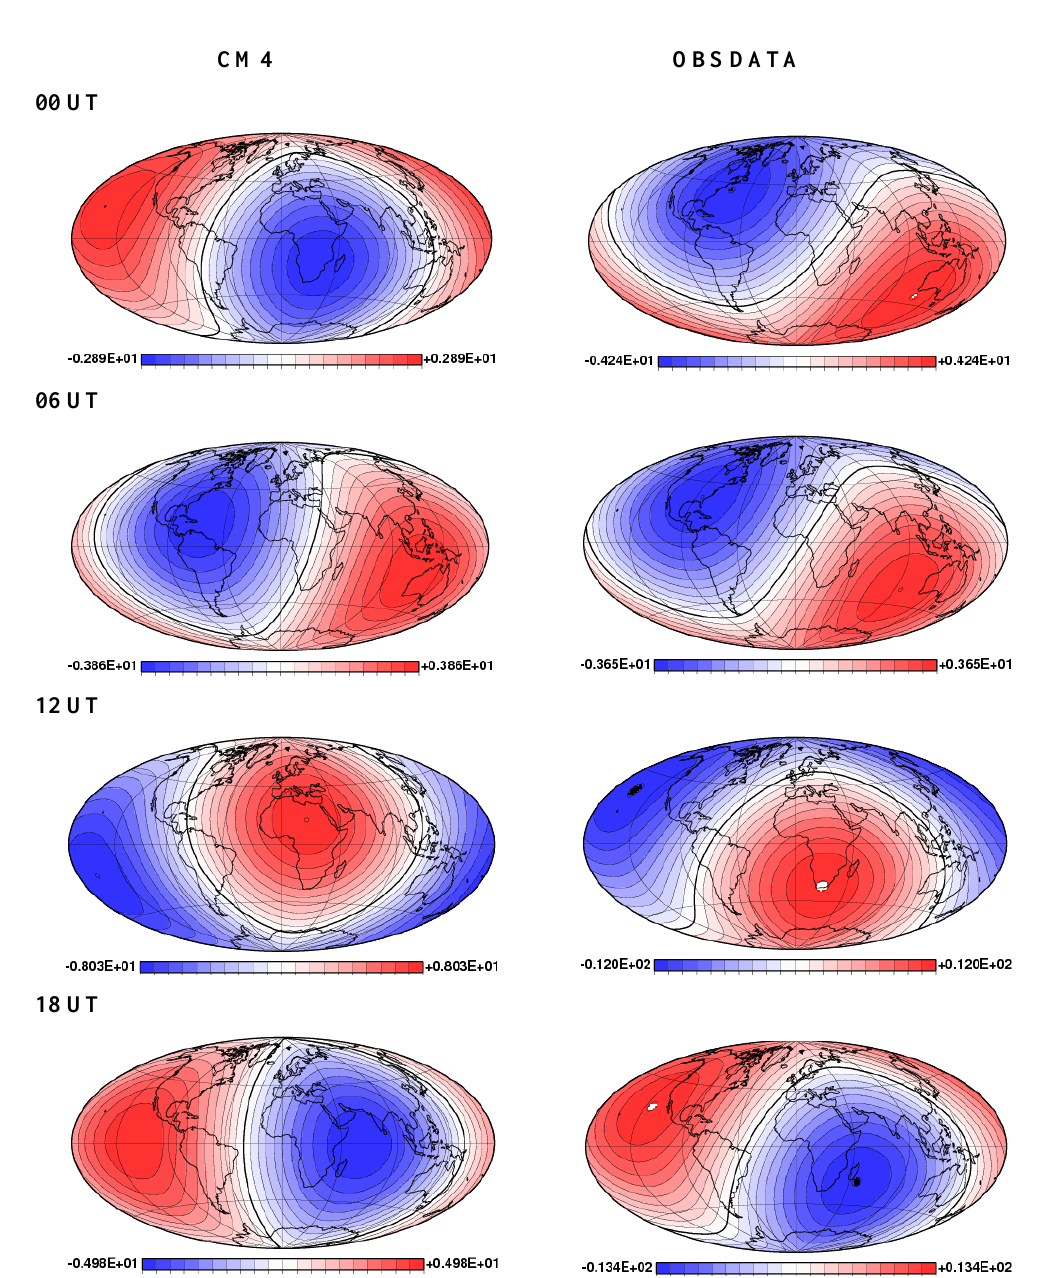
Figure 5. CM4 observatory data comparison of the Z component of the geomagnetic diurnal variation field measured at the Earth’s surface at moderately disturbed time, at spherical harmonic degree truncation n = 1. Left-hand panels are models of data synthesised from the CM4 while right-hand panels are the observatory station data. Note much can be deduced from the map at n =